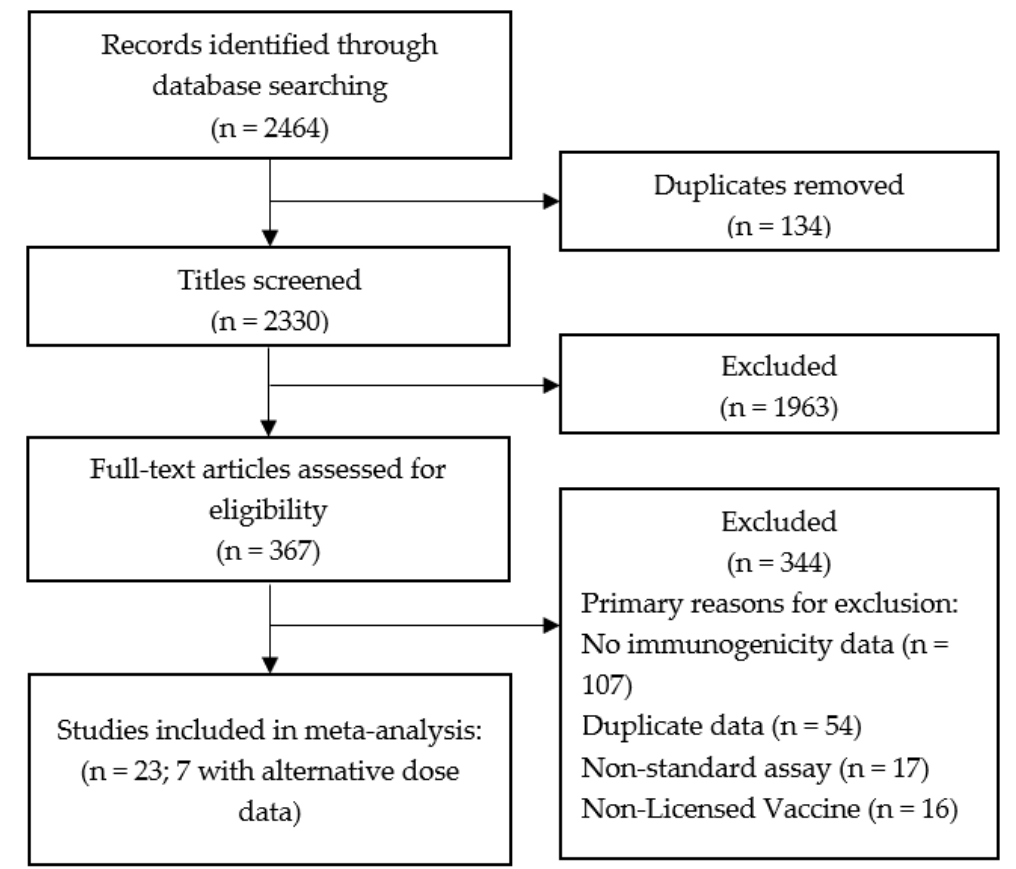
Figure 1. PRISMA diagram.